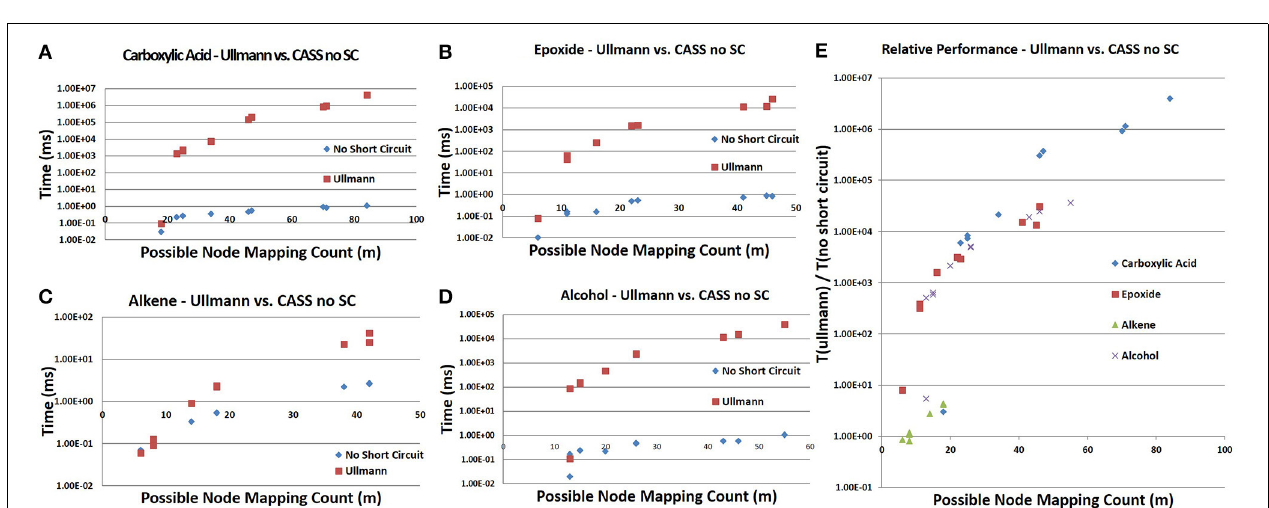
FIGURE 10 | Direct comparison of the Ullman algorithm to CASS with no short circuiting. (A–D) For all four functional groups, our algorithm shows linear performance at these values of m while the Ullmann algorithm does not.